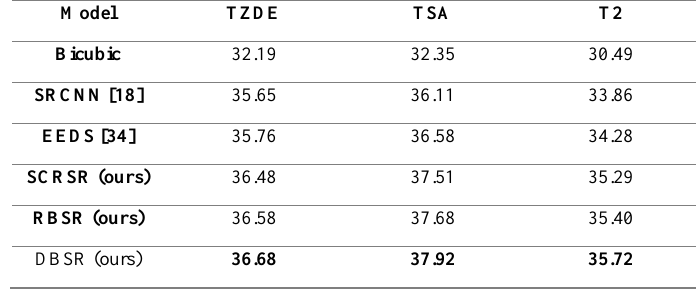
Table 1. Evaluation results on the T2 dataset using PSNR metric and scale factor 2.